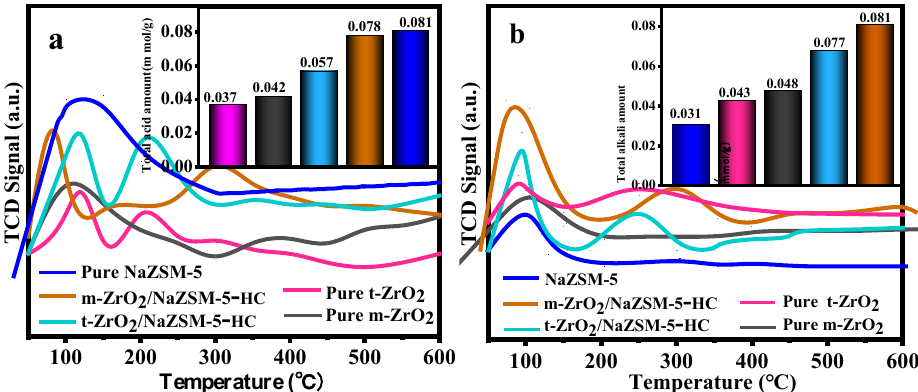
Figure 4. TPD spectra of different catalysts: ( a ) NH 3 -TPD and ( b ) CO 2 -TPD.